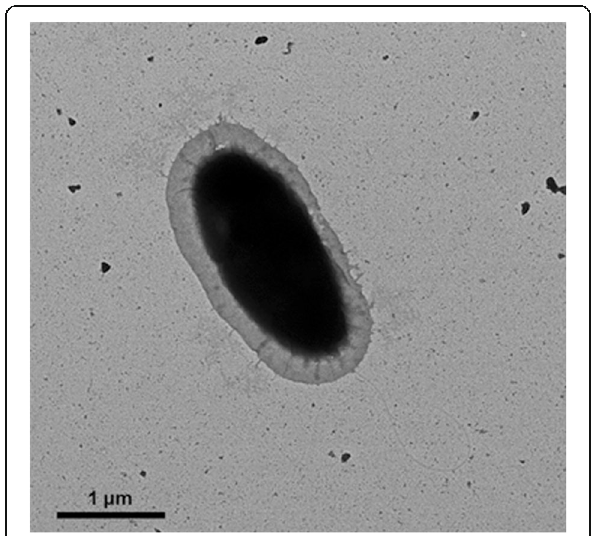
Fig. 2 Transmission electron microscopy image of Marinobacterium rhizophilum CL-YJ9 T